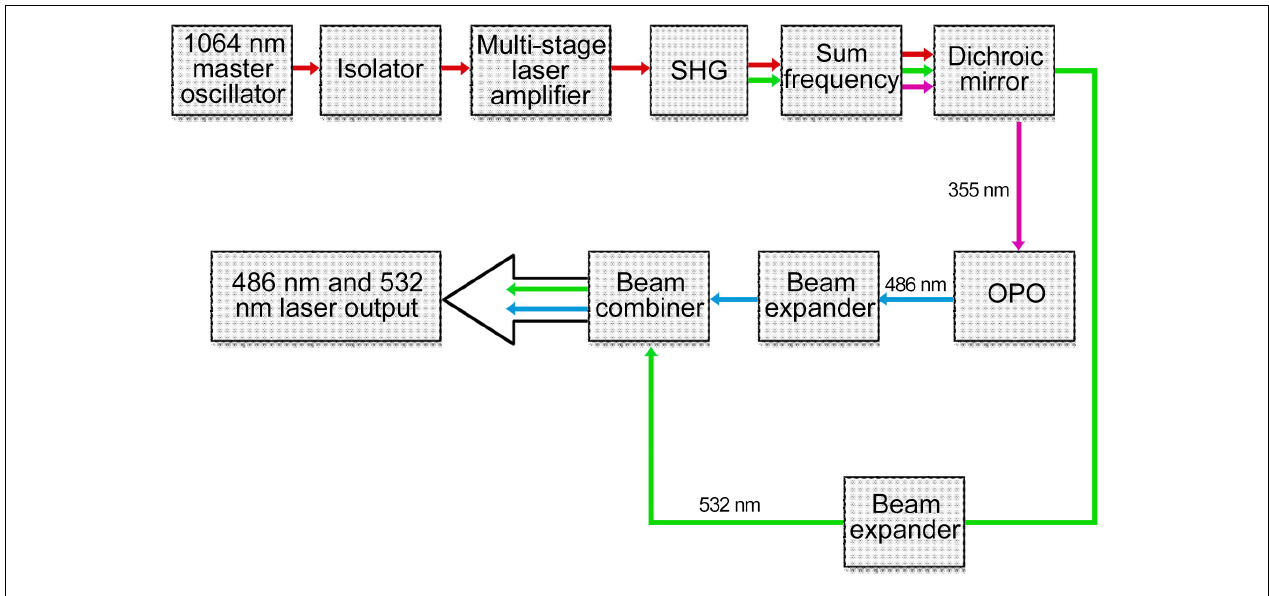
FIGURE 8 | Component diagram of the Guanlan ocean